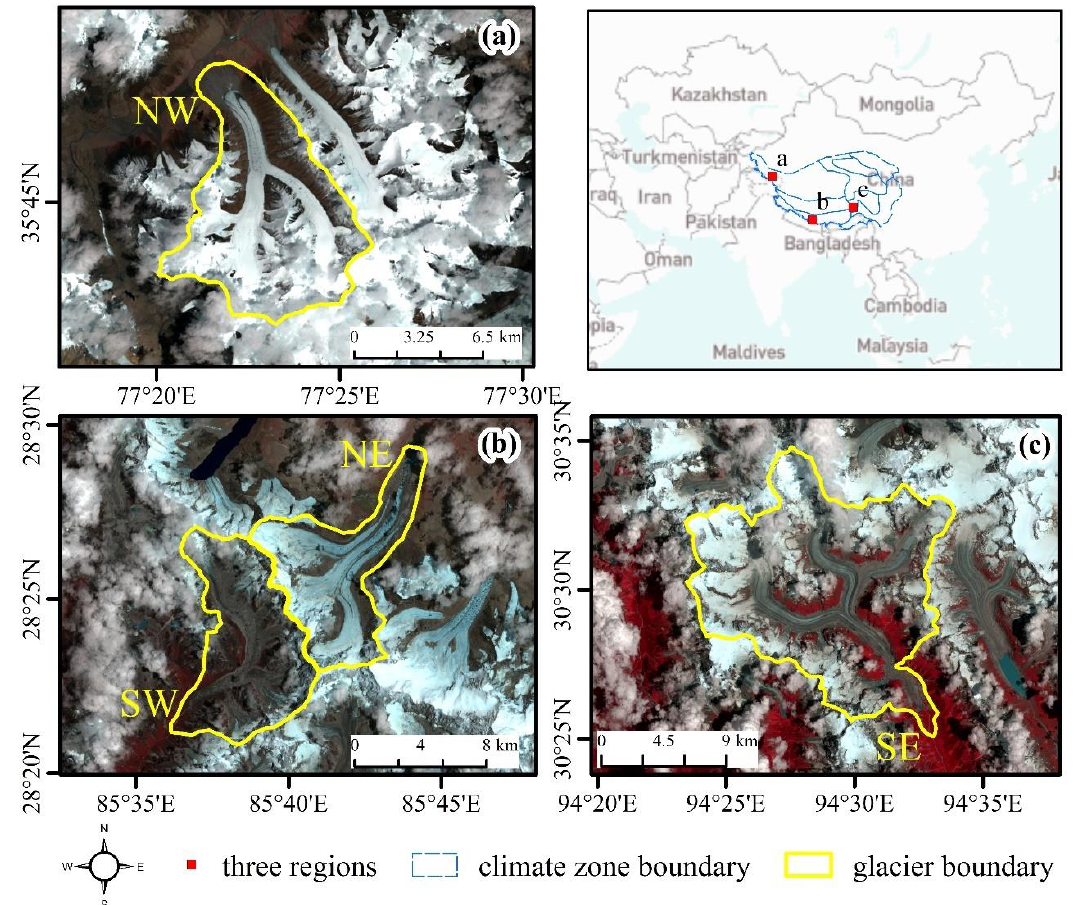
Figure 1. The topography base map of the Tibetan Plateau (TP) with three insets showing four glaciers in three different climatic zones. The four glaciers were selected as our study sites based on the main aspect of the glacier flow line. The black polygons show the boundaries of the different climatic zones on the Tibetan Plateau (14 June 2020). The red squares a-c in the upper-right diagram correspond to the glaciers in each of the three climate regions, as shown in figures ( a – c